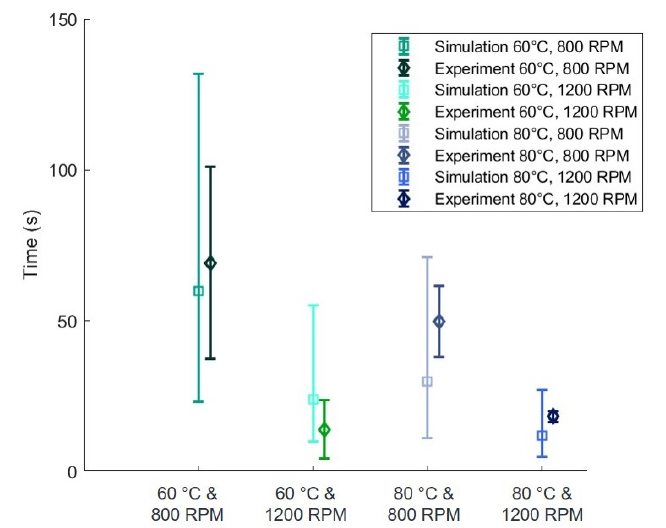
Figure 16. Comparison of the experimentally measured times with the numerically calculated times for reaching the sensor with the matrix. Table 11. Deviations of simulation results and measured mean values for reaching the